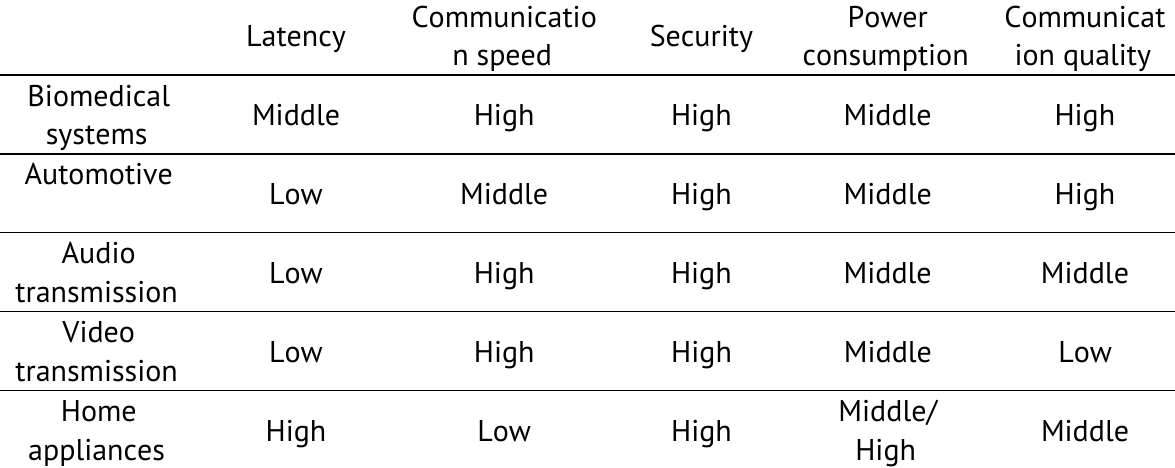
Communication requirements for